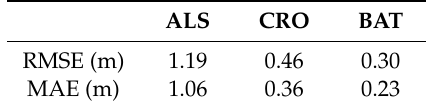
Table 6. RMSE and MAE errors for the compared DEMs (channel comparison).